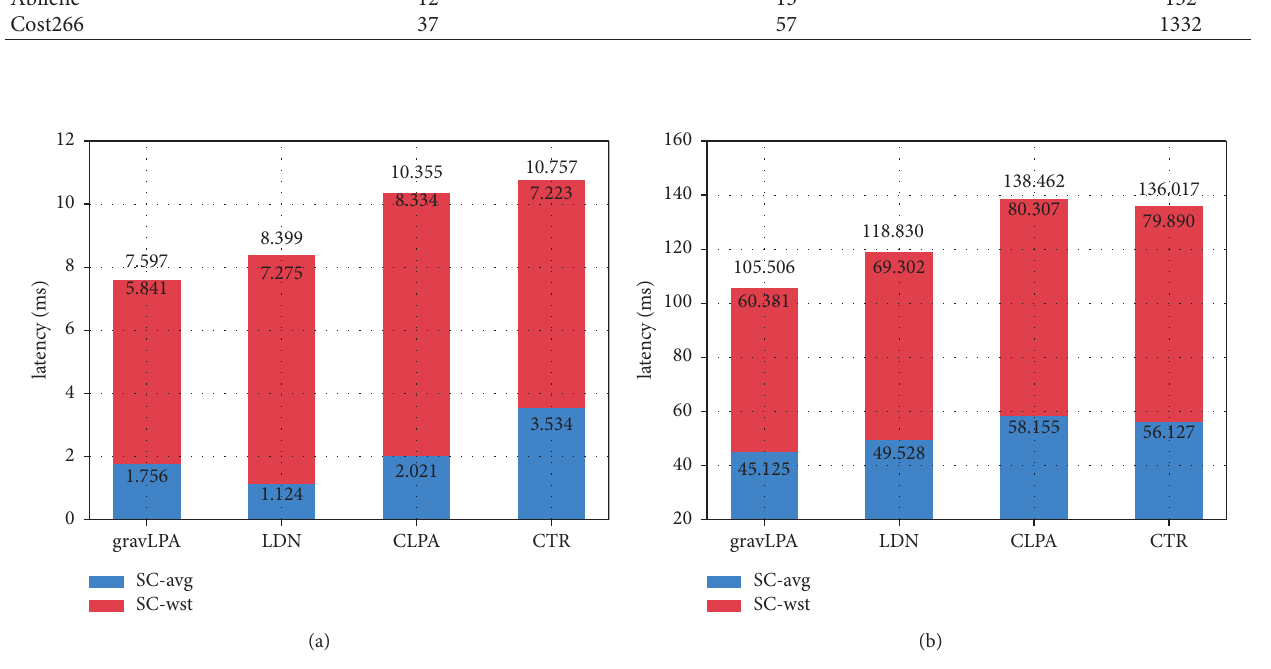
Figure 8: The latency of CPP algorithms in real